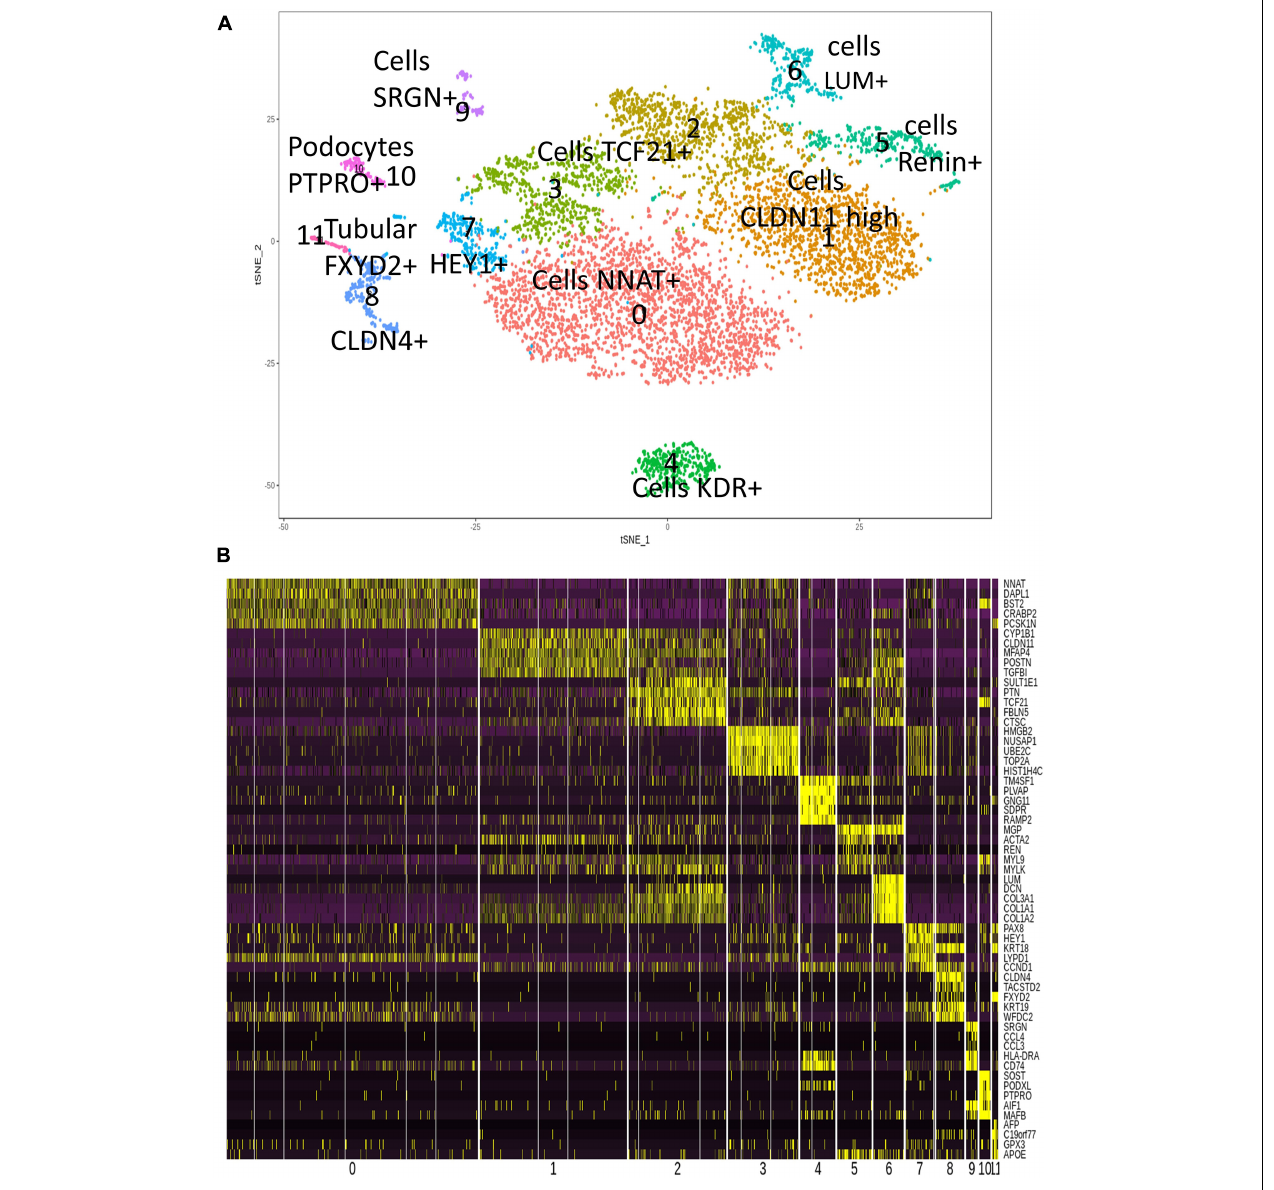
FIGURE 1 | Cell heterogeneity in human fetal kidney cortex by single-cell transcriptome. (A) t-Distributed stochastic neighbor embedding (tSNE) plot with 11 cell clusters from the combined analysis of the merged fetal kidney cortex (two human kidneys, 17 weeks; 7,860 cells) after canonical correlation. (B) Heatmap with the expression pattern of the top five cluster-specific genes in 11 clusters identified in human fetal kidney